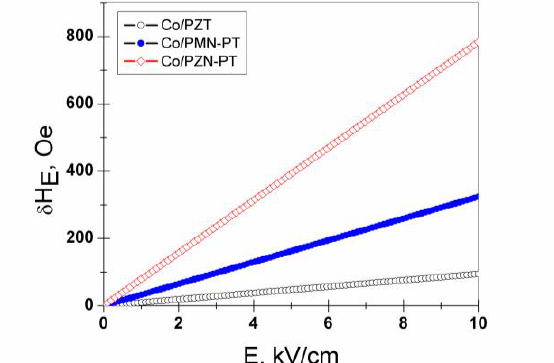
Fig. 2. Result of the FMR line shift calculation for composite structures of Fe/PZT, Fe/PMN-PT and Fe/PZN-PT. Results for Co deposited on PZT, PMN-PN and PZN-PT are shown on Fig. 3.